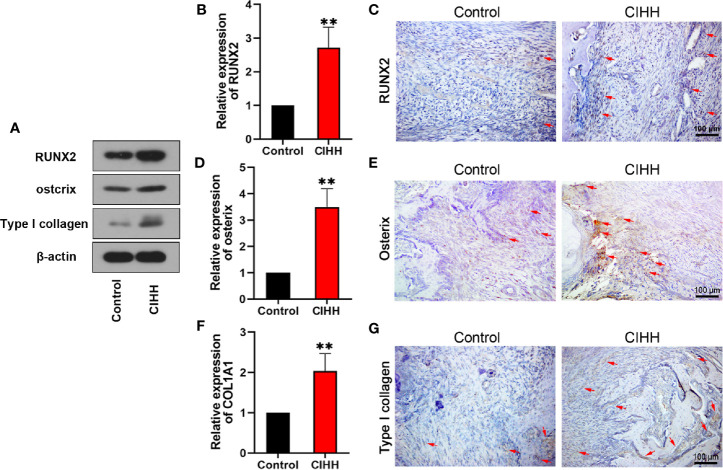
Bone formation. Protein levels of RUNX2, ostcrix, Type I collagen (A). mRNA expression level of RUNX2 (B), osterix (D), and COL1A1 (F) of the callus ares. Immunohistochemistry of RUNX2 (C), osterix (E), and type I collagen (G) within the callus area. Magnification, ×200, scale bar = 100 µm. The typical positive stained cells or regions were indicated by arrows. n=6, Mean ± SD, **p < 0.01.